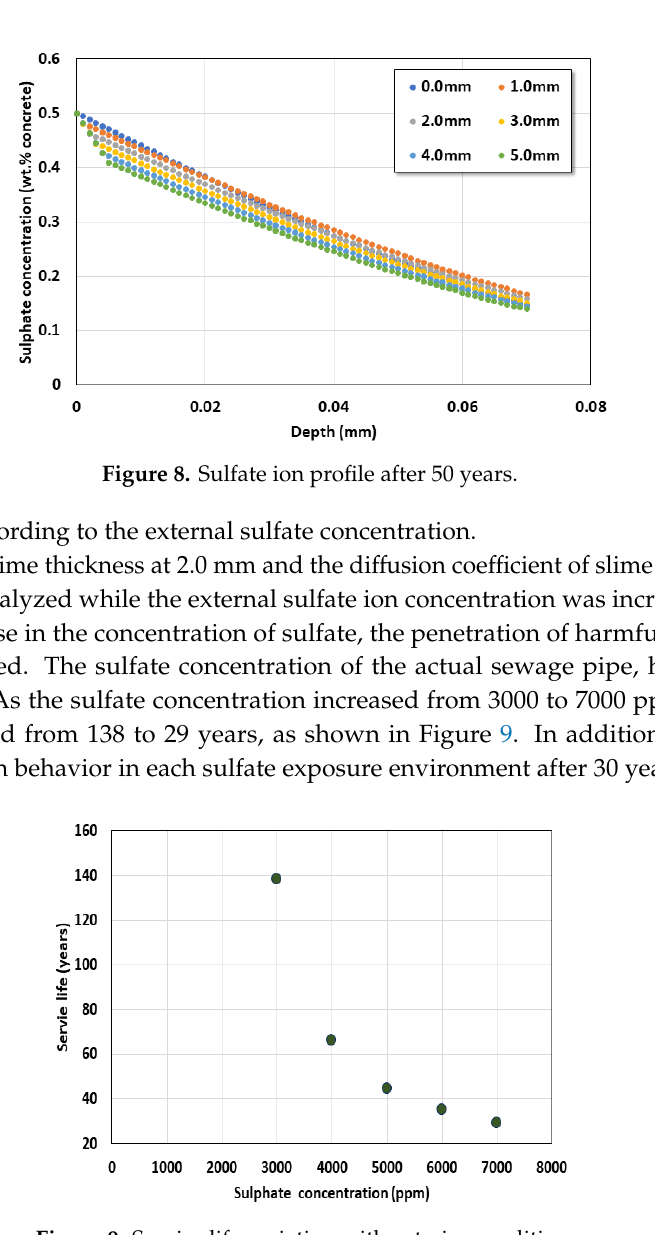
Figure 6. ( a ) Sulfate ion profile with cover depth after 49.1 year; ( b ) increasing sulfate ion at steel location with time.